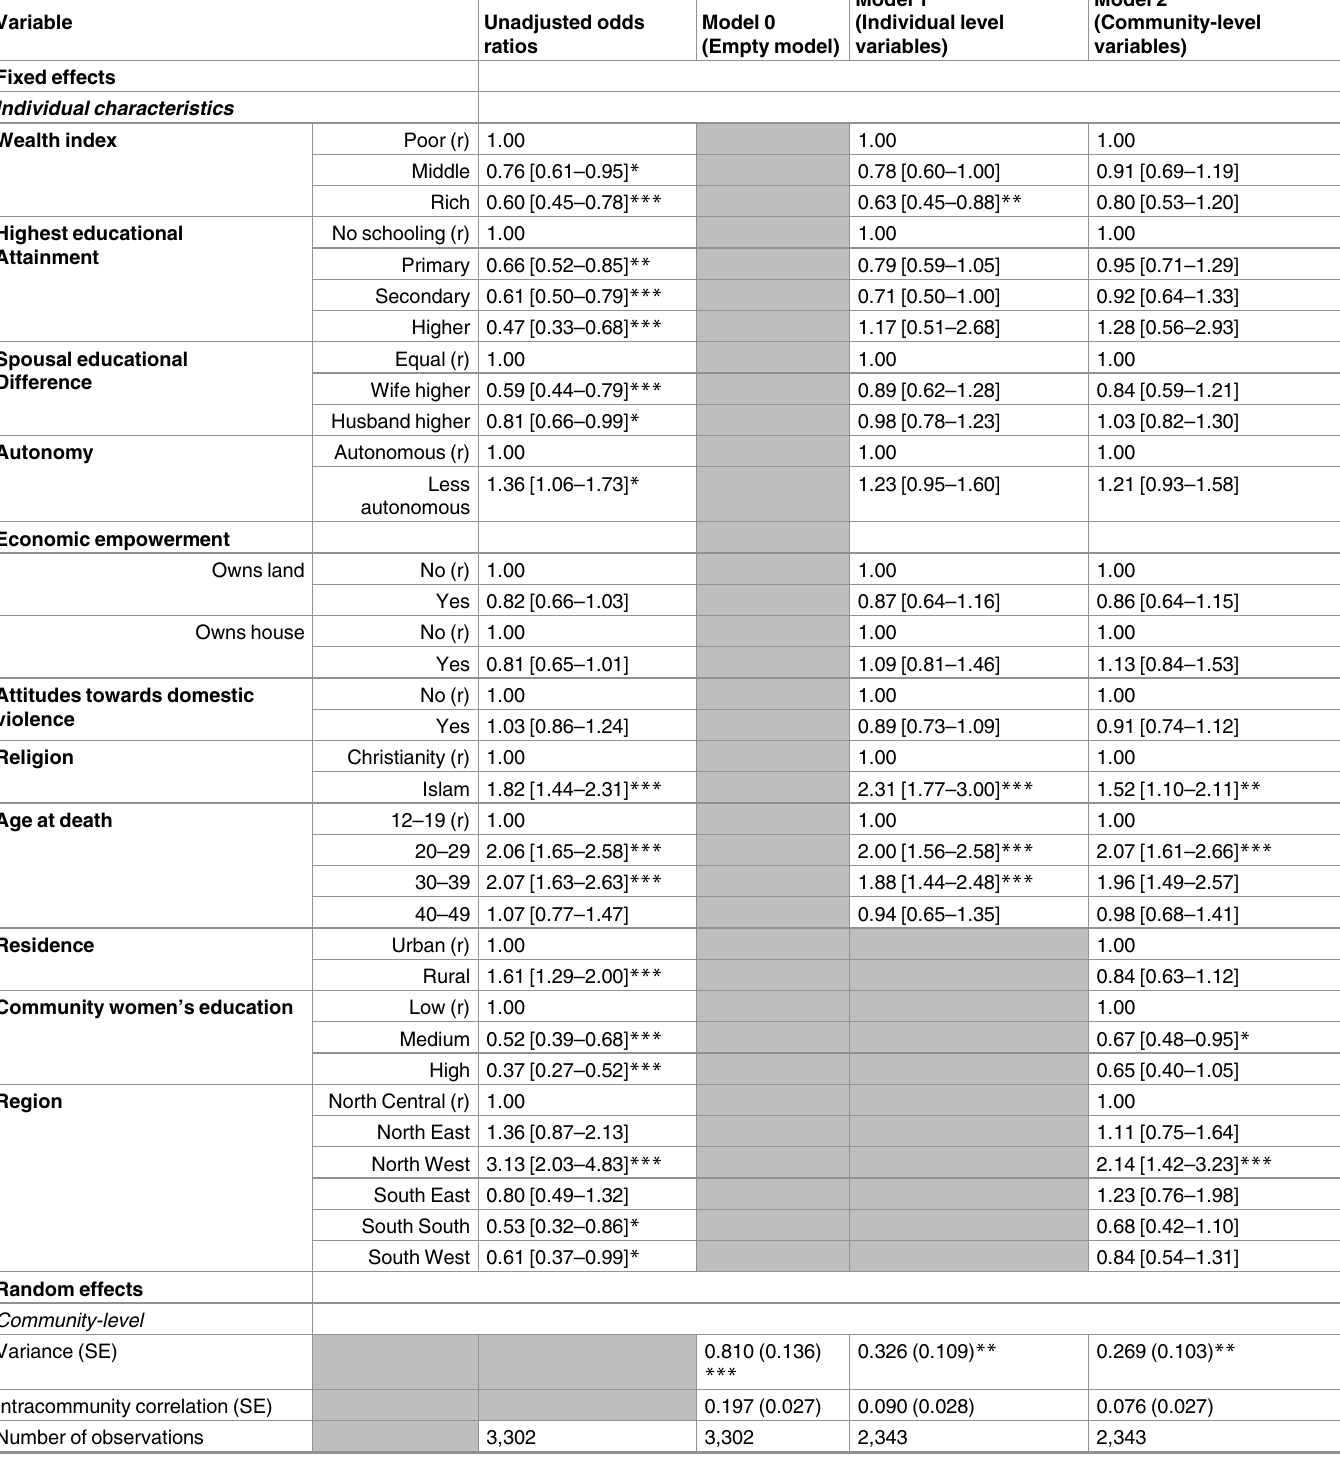
Table 5. Odds ratios and 95% confidence intervals for multilevel logistic regression models of maternal mortality on selectedcharacteristics, Nigeria Demographic and Health Survey